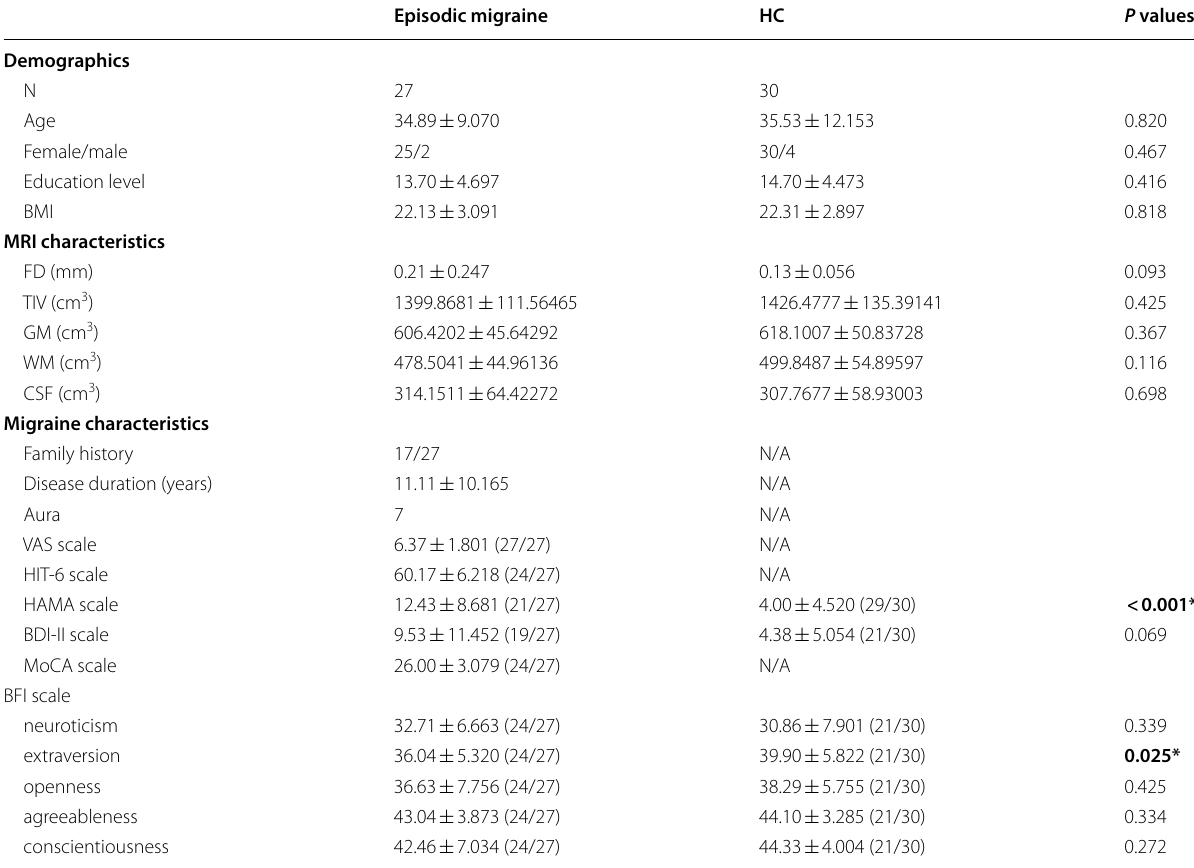
Table 1 Demographic, clinical, and MRI characteristics of patients with episodic migraine and